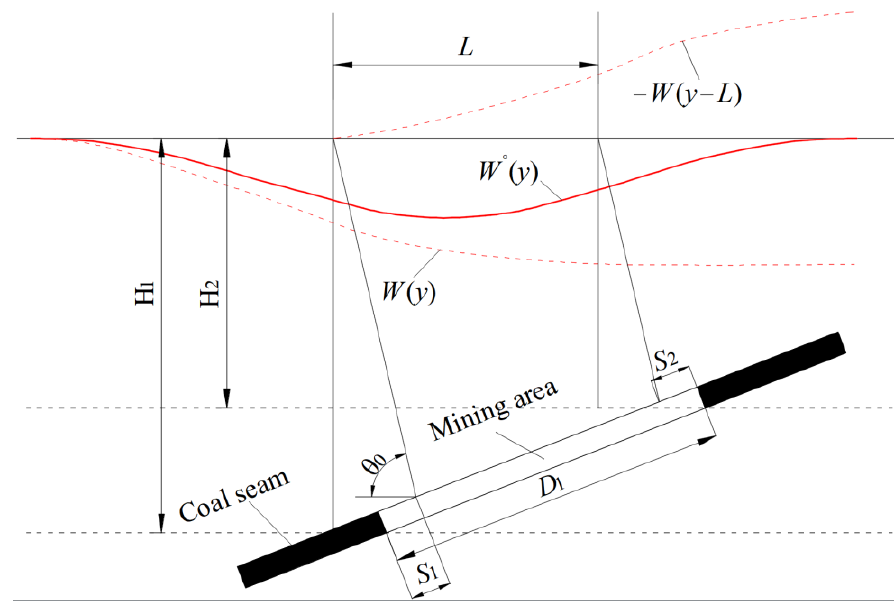
Figure 7. Surface subsidence in the main section of the limited mining